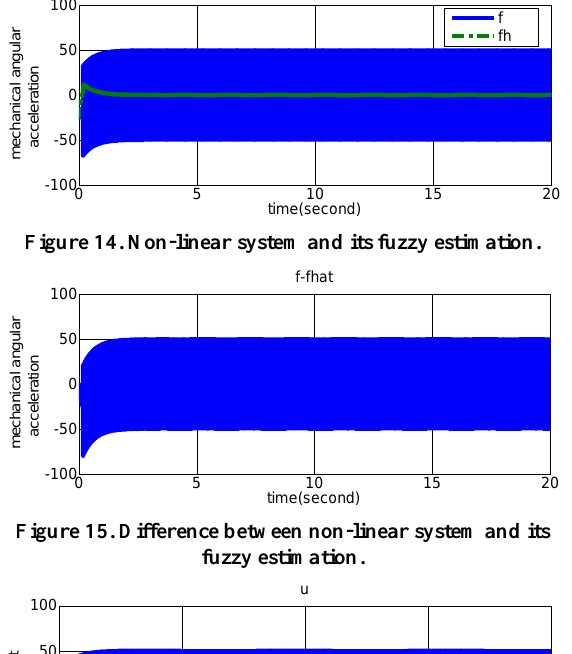
Figure 11. Adaptive weight of fuzzy system.